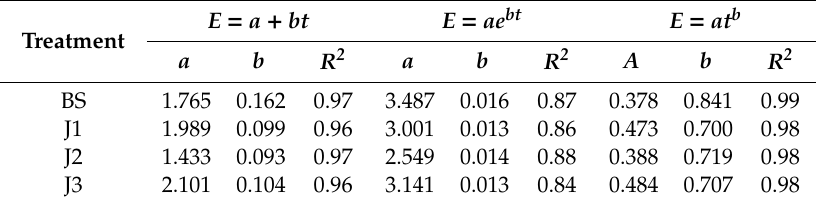
Table 2. Fitting equation analysis of cumulative evaporation and time for different straw mulch modes.